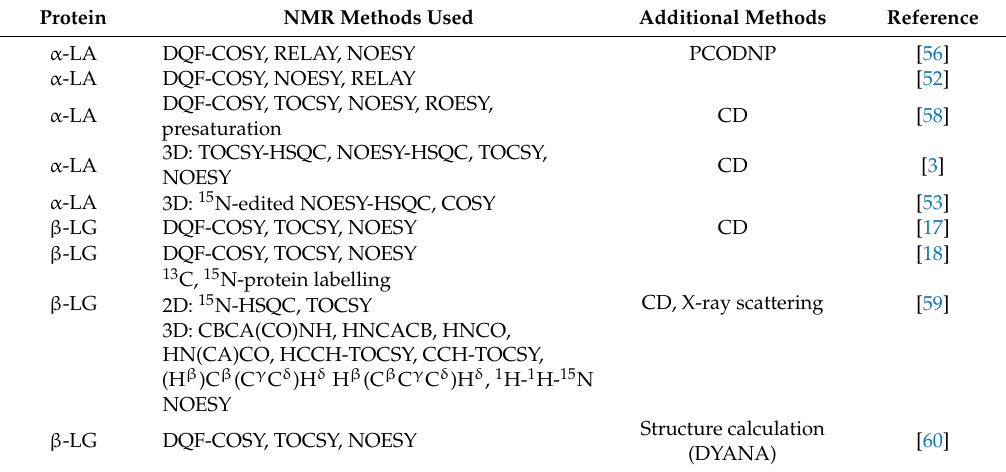
Table 1. NMR structural studies on α -LA and β -LG, including the performed NMR methods